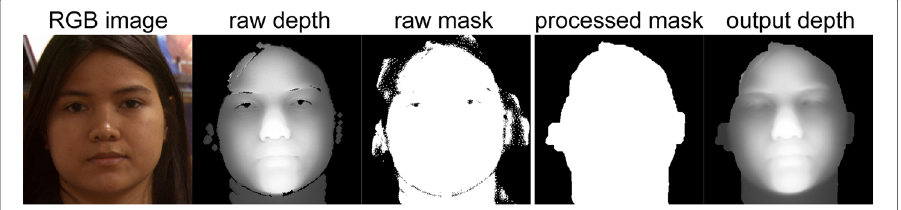
Fig. 5 Depth map processing. An example of depth map interpolation for RGB-D scans based on the processed